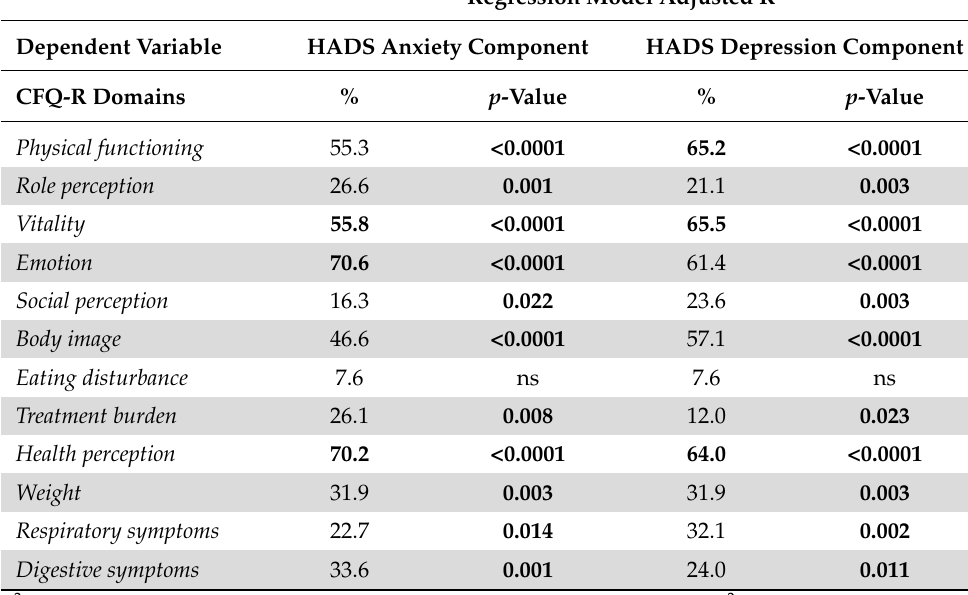
Table 4. Multiple regression analyses for the Cystic Fibrosis Questionnaire-Revised (CFQ-R) in CF adults for HADS anxiety and depression.